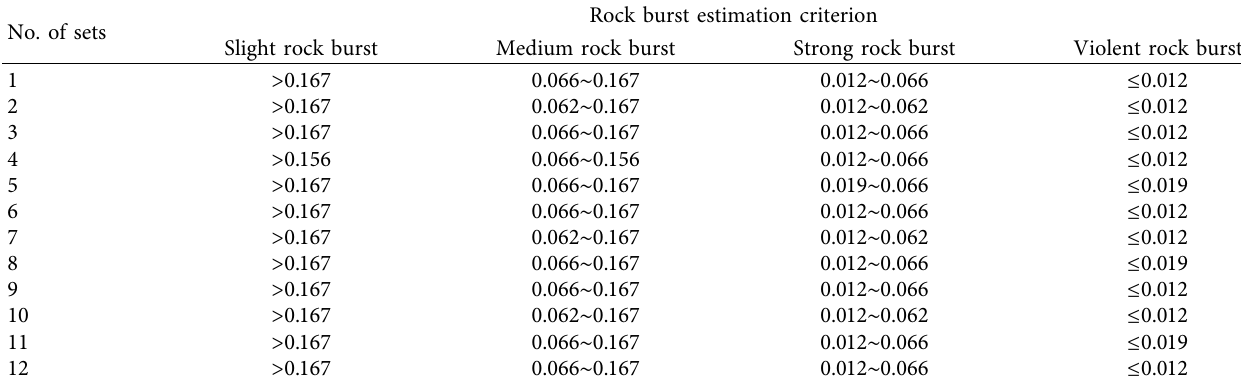
Table 12: Estimation criteria of rock burst grades under different conditions.